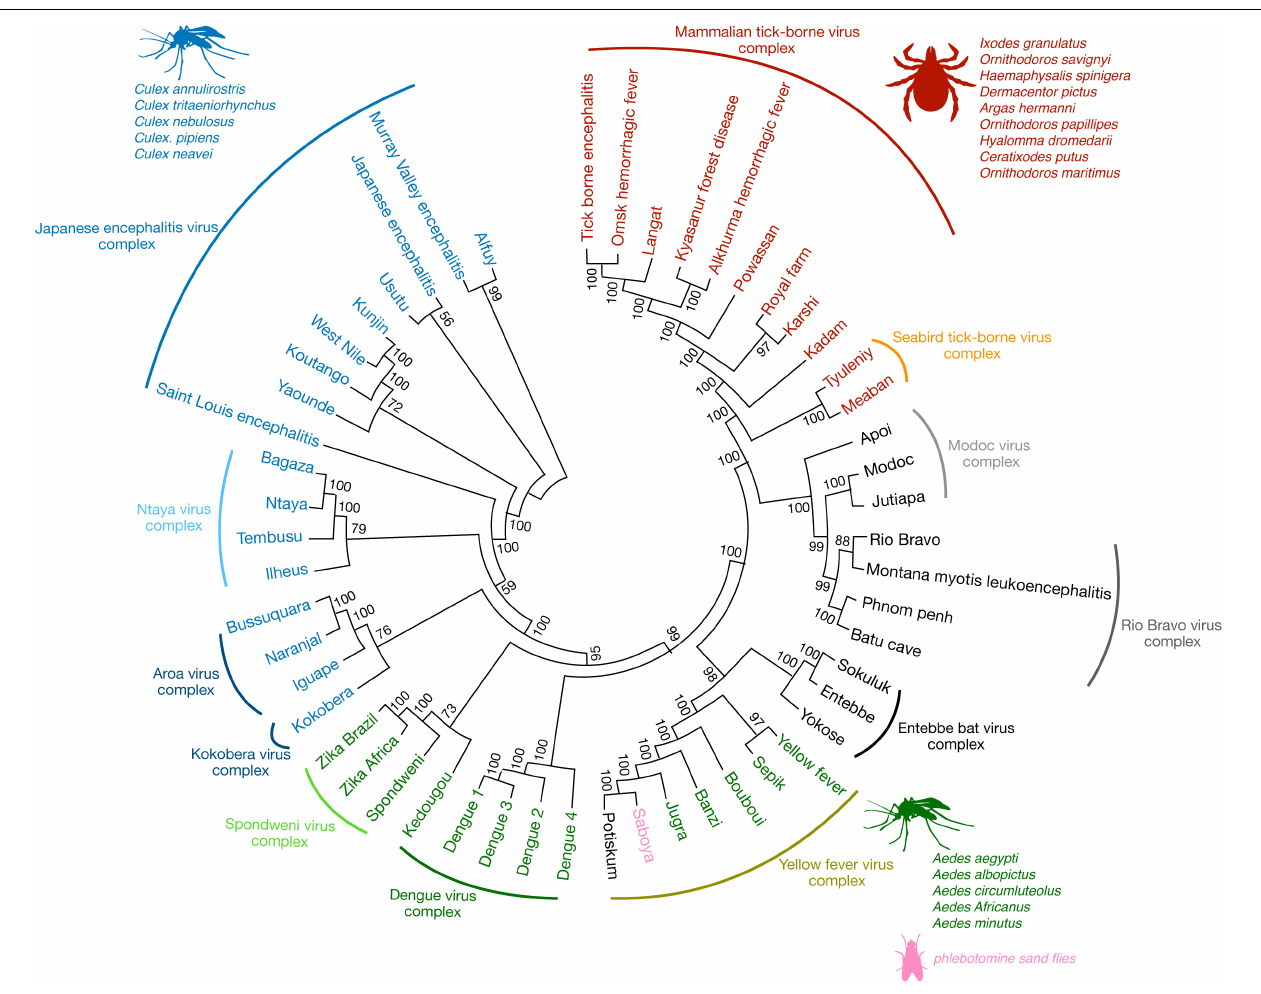
FIGURE 1 | The antigenic relationships among flaviviruses. Phylogenetic analysis demonstrates that flaviviruses cluster not just antigenically but also group according to their known transmission vectors. Some of the most significant flaviviral human pathogens belong to the JEV, Spondweni, DENV, YFV, and mammalian TBV serocomplexes, respectively (arched lines cover viruses of the same serocomplex). Some of their most common vectors are also listed, such as the mosquito species Culex (blue) and Aedes (green) and various species of ticks (red). Other flaviviruses have no known vector, for example, viruses of the Modoc, Rio Bravo, and Entebbe bat virus complex (black). Among the Aedes mosquito-borne viruses of the YFV serocomplex, Saboya virus (pink) has been successfully isolated from the phlebotomine sand flies (85). Phylogenetic analysis was conducted using molecular evolutionary genetic analysis (MEGA-7) software (86). The full-length polyprotein amino acid sequences from various flaviviruses were obtained from the NCBI database and pairwise aligned using Clustal W. The phylogenetic tree was constructed by using the maximum likelihood method based on the Jones-Taylor-Thornton (JTT) matrix-based model (87). The consensus tree representing 200 bootstrap is presented (88). Branches that were reproduced in less than 50% bootstrap replicates are collapsed. The nodes show bootstrap support values from